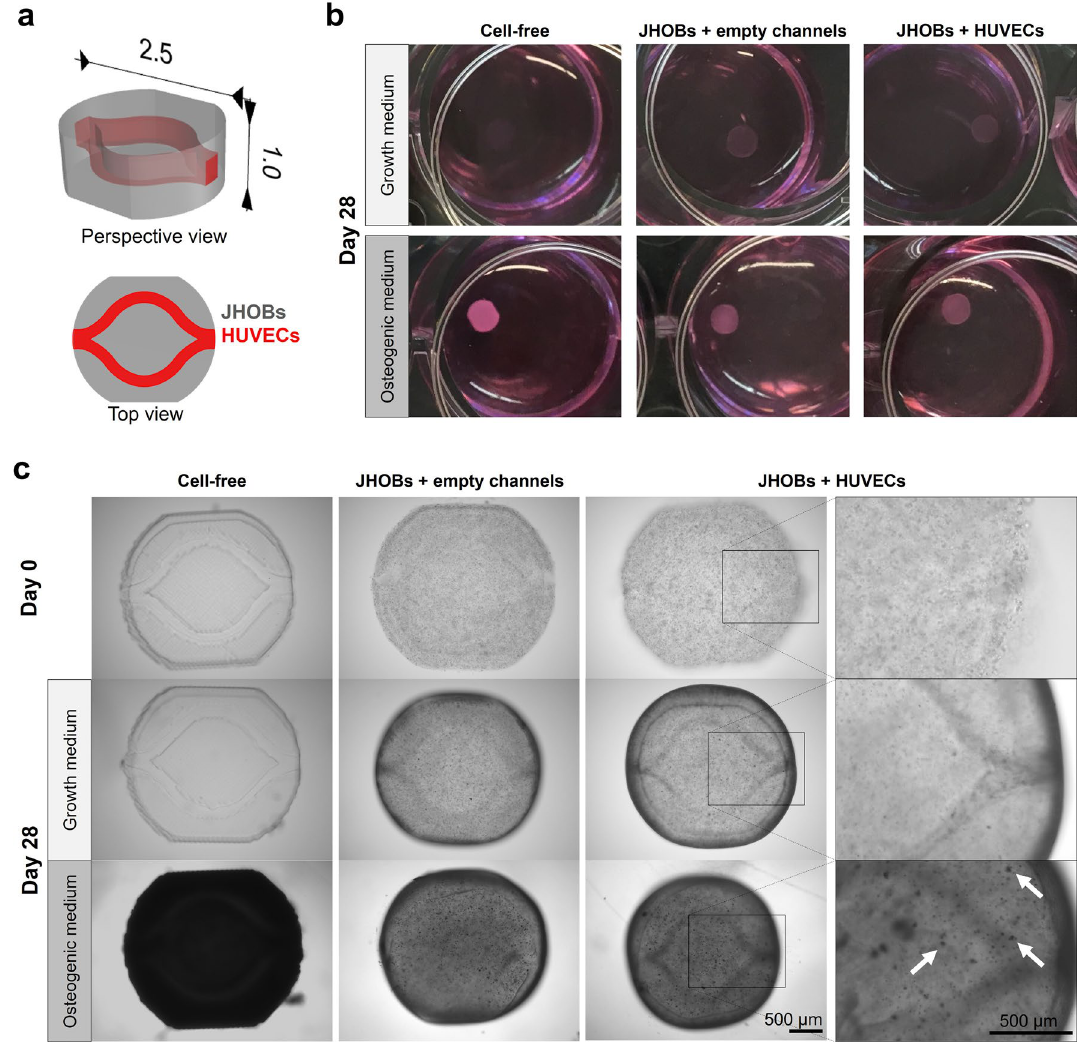
Figure 2. Fabrication and cultivation of the bioprinted human jawbone models. ( a ) CAD file of the jawbone model. Dimensions are given in mm. ( b ) Macroscopic images of the prints after 28 days of cultivation. ( c ) Microscopic images of the prints on day 0 and after 28 days of cultivation. White arrows indicate deposited